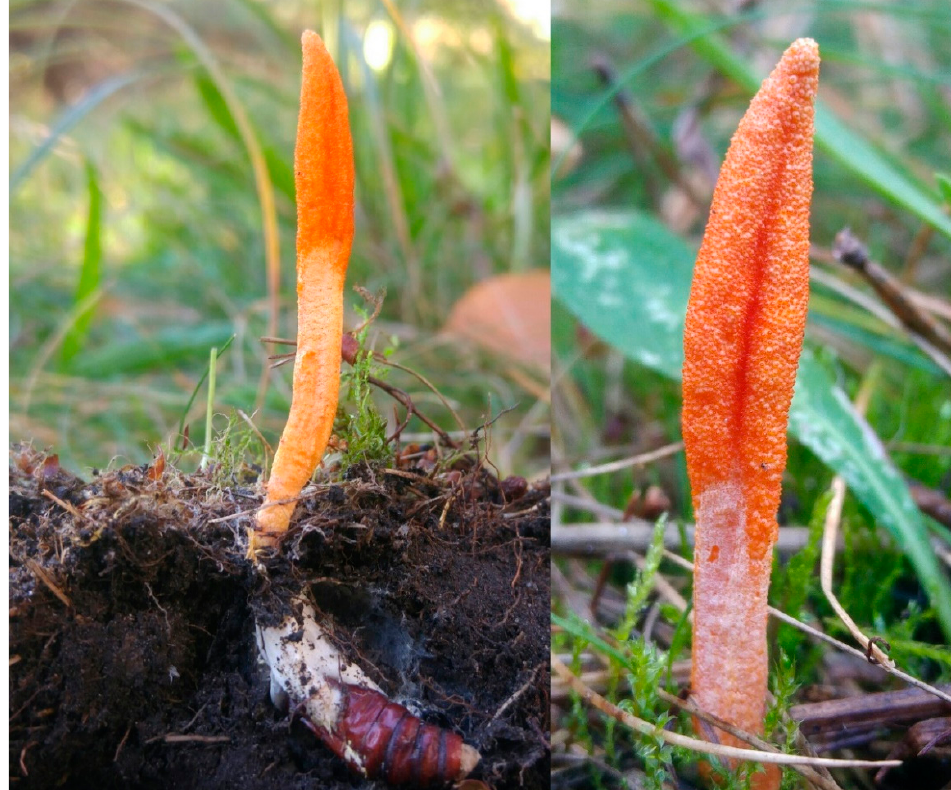
Figure 2. Cordyceps militaris in its natural habitat (photo by Pawe ł Stasiowski).